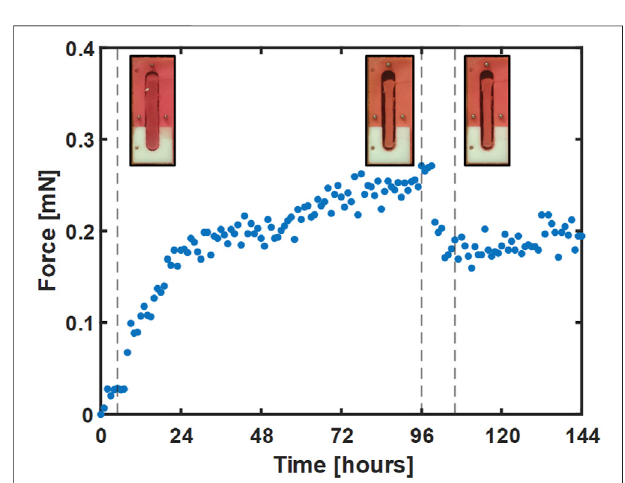
FIGURE 6 | A representative plot of the force response for a single gel treatedwith blebbistatin at 96 h. Images ofgel de fl ection correspondto5, 96, and 105 h and are marked with dotted